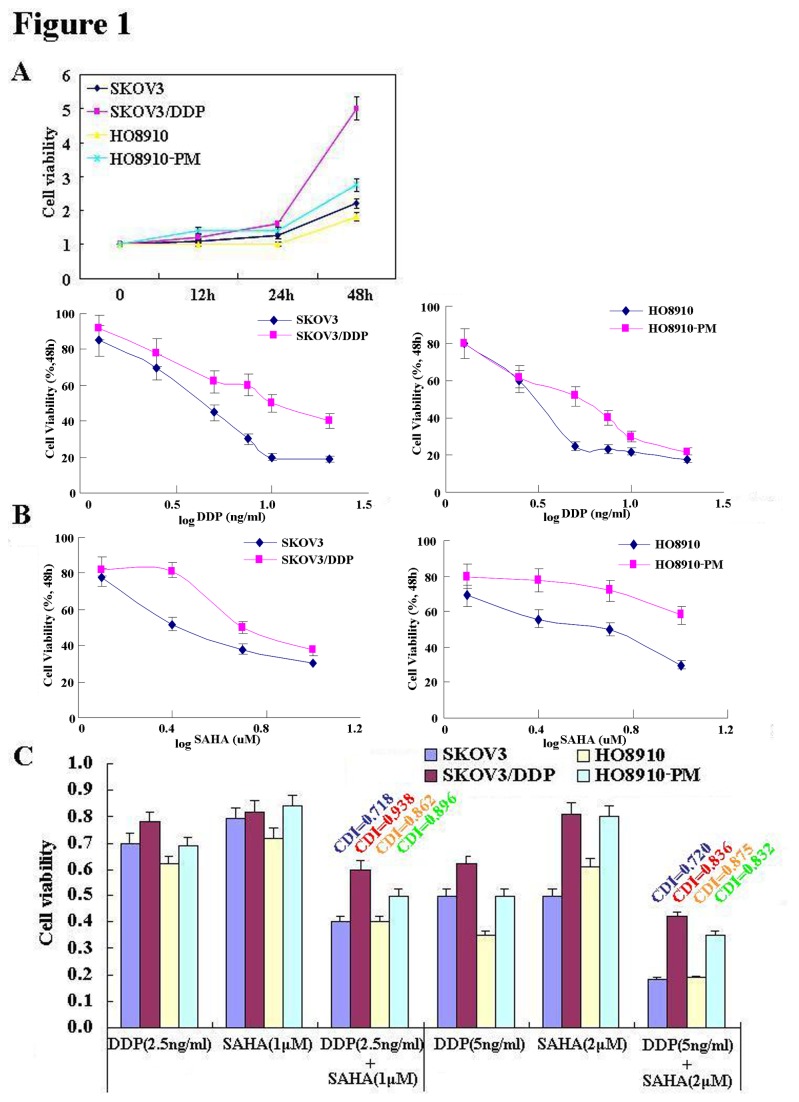
The effects of cisplatin (DDP) and SAHA on the proliferation of ovarian carcinoma cells.CCK-8 cell proliferation assays(n=3) showing that DDP (A) and SAHA (B) treatment of SKOV3 and SKOV3/DDP and HO8910 and HO8910-PM cell-line pairs induce cell death in a concentration- and time-dependent manner; furthermore, DDP and SAHA exhibit a synergistic effect when both treatments are applied in combination (C).